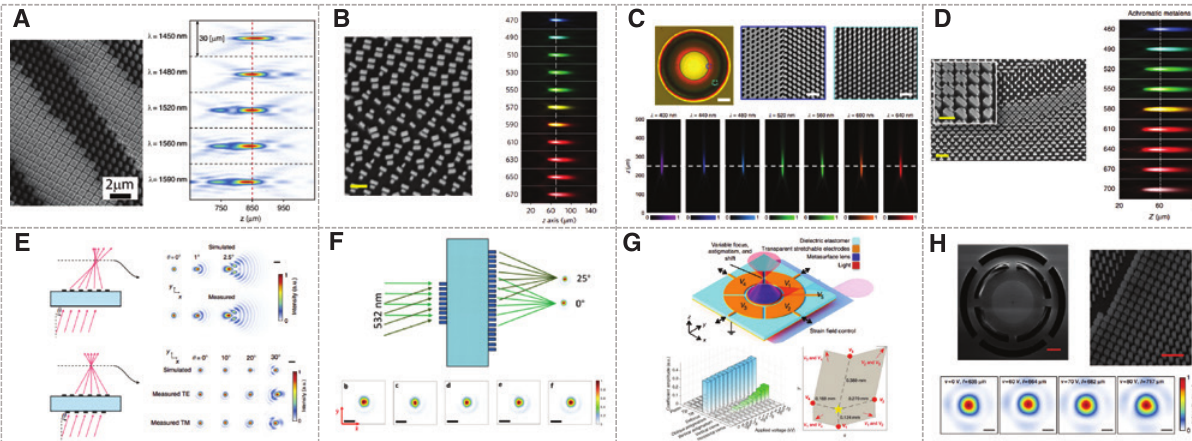
Figure 7: Metalenses for correction of intrinsic aberrations (A–D). One is the fabricated sample, and the other is the representative result of achromatic metalens, showing intensity profile with distinct wavelengths. (A) Dielectric metasurfaces for control of the chromatic dispersion in near-infrared region [22]. (B) TiO for achromatic focusing in the visible spectrum using the PB phase with designer meta-atoms [125, 126]. (D) Polarization-insensitive metalens operating in visible frequency [128]. (E–F) Metalens doublet corrected for the monochromatic aberrations [129, 130]. (E) The left two figures for schematic and corresponding right figures imply the difference in aberrations, which is severe at singlet (top), while it is improved in the doublet case (bottom). (F) The left figures show the mechanisms, and the right shows the measured results regarding illumination angle. (G–H) Representative tunable metalenses [131, 132]. (G) Adaptive metalens that can tune the focal point and astigmatism as well [131]. The upper image shows the brief mechanism of the proposed structure, and the lower graphs show the performances. (H) Metalens integrated with micro electro mechanical systems (MEMS) for focal length control